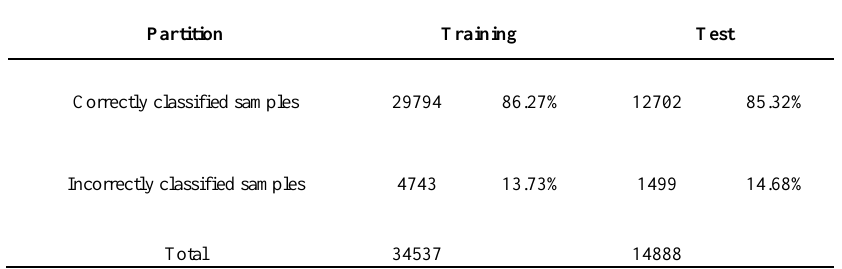
Table 12. Accuracy of decision tree of Pin Pad transactions regardless of month and year.